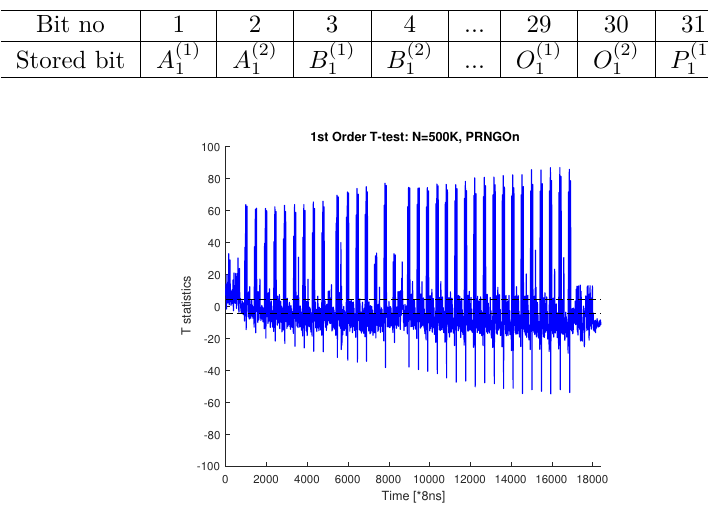
Figure 7: 1st Order TVLA on the AES Sbox